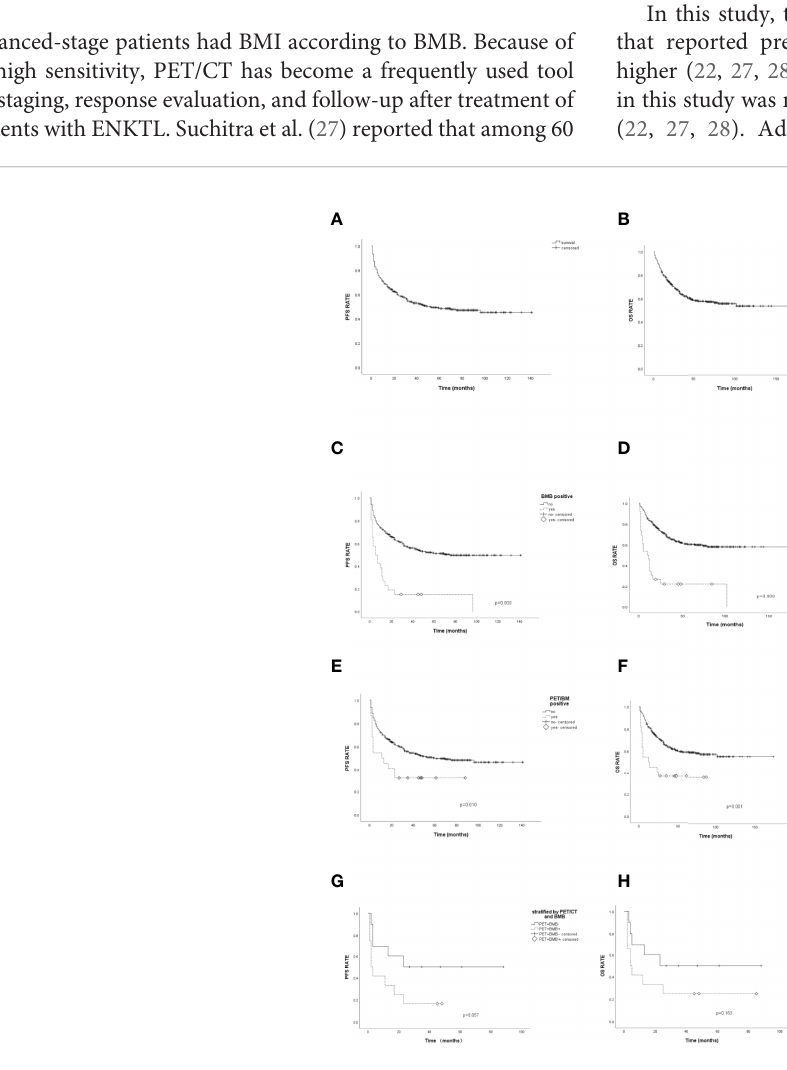
FIGURE 2 | Progression-free survival (PFS) and overall survival (OS) analysis. (A, B) : The median PFS (mPFS) and median OS (mOS) of 356 patients was 51.0 months and 144.0 months. (C) The mPFS of bone marrow biopsy (BMB) positive was 5.0 months, and 75.0 months for negative patients, p =0.000. (D) . The mOS of BMB positive was 10.0 months, and 144.0 months for negative patients, p =0.000. (E) The mPFS of PET/BM positive was 11.0 months, and 60.0 months for negative patients, p =0.010. (F) The mOS of PET/BM positive was 12.0 months, and 144 months for negative patients, p =0.001. (G) The mPFS of patients with PET/ BM false positive (PET+BMB-) and PET/BM true positive (PET+BMB+) were 23.0 months and 2.0 months, respectively, p =0.057. (H) The mOS of patients with PET/ BM false and true positive were 23.0 months and 4.0 months, respectively, p